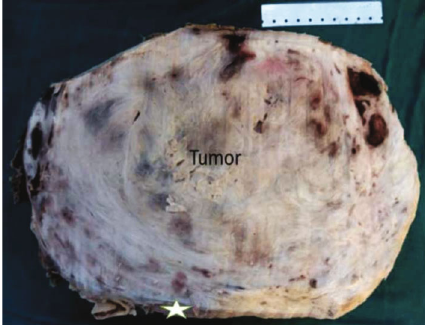
Figure 2: Gross examination of the tumor showed a gray-white whorled appearance with foci of hemorrhagic and necrotic changes. Presence of a peripheral rim of the normal kidney